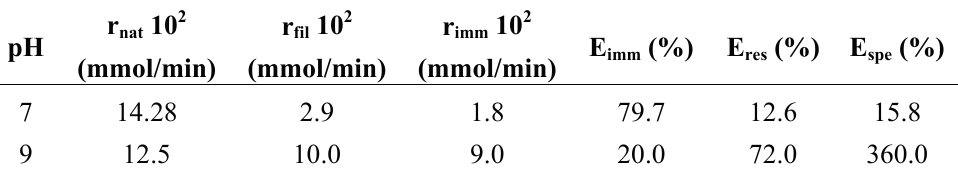
, residual activity, E , and specific imm res , determined from the corresponding values of spe , the activity of the filtrate in nat , and the activity of the immobilized enzyme, r , for the fil imm